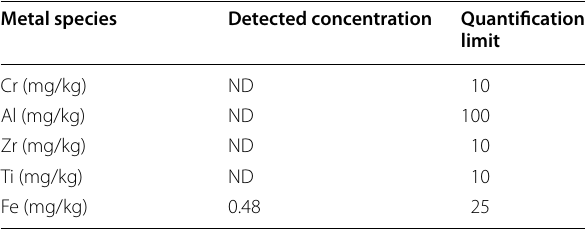
ND not detected, Quantification limit: quantification limit possible with ICP- = OES, from EN ISO 17072-1-2019